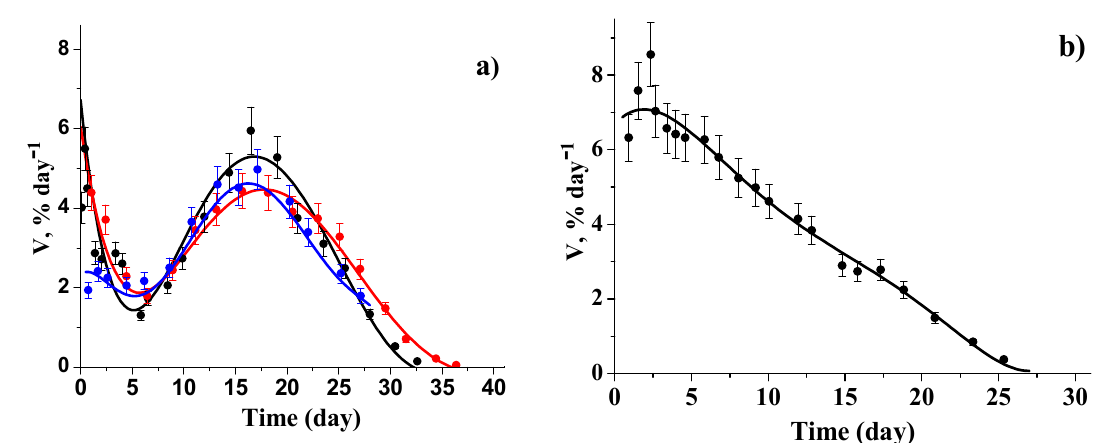
Figure 13. Di ff erential kinetic curves for the dopants release from PDL 02 films: TEMPOL / 200 µ m films (black and red symbols) and ATI / 200 µ m film (blue symbols) ( a ), and TEMPOL / 50 µ m film ( b ). Figure 13. Differential kinetic curves for the dopants release from PDL 02 films: The lines are the result of polynomial fitting. TEMPOL/200 μ m films (black and red symbols) and ATI/200 μ m film (blue symbols) ( a ), and TEMPOL/50 μ m film ( b ). The lines are the result of polynomial fitting.